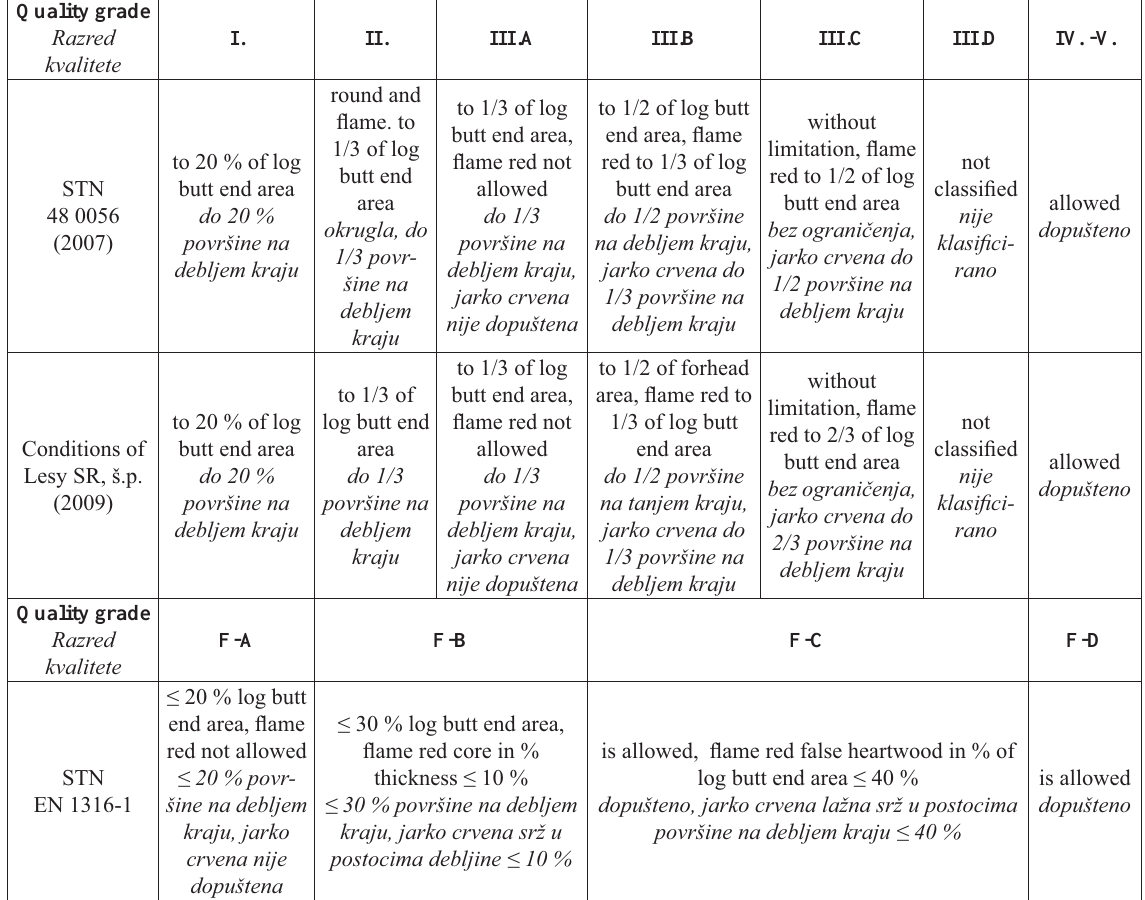
Table 1 Assessment of the size of false heartwood of specifi c assortment quality, according to most commonly used technical standards in